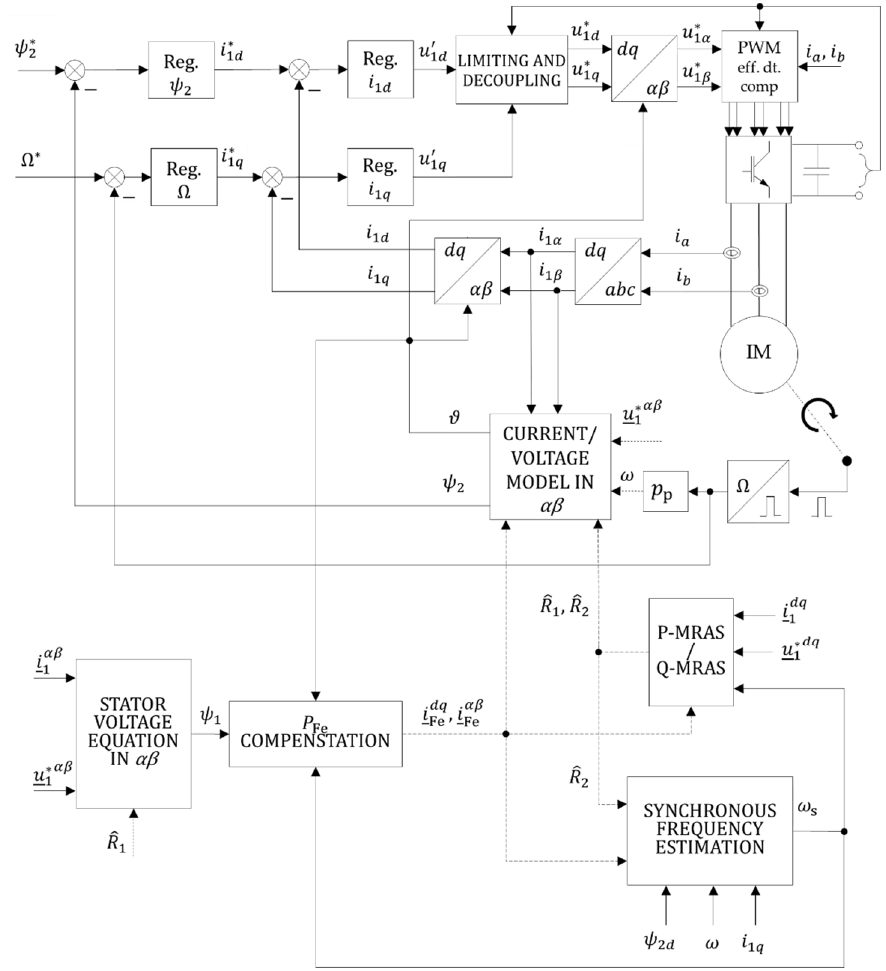
Figure 7. Block diagram of the utilized direct field-oriented control.